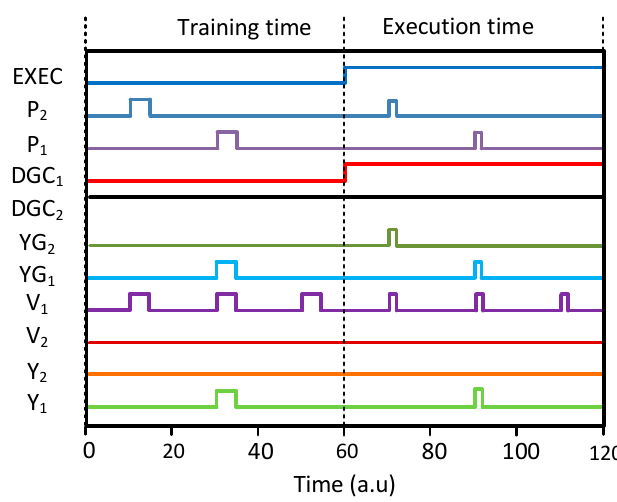
Figure 4. The simulated waveforms of the memristor crossbar with the parting gating.